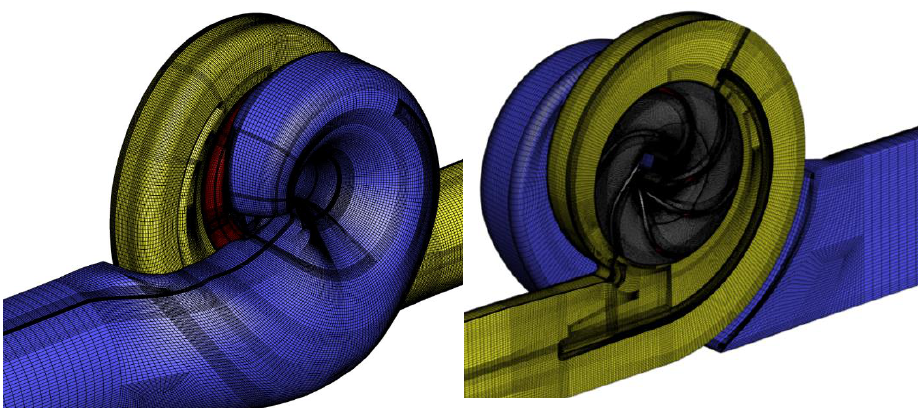
Figure 9. Multi-block structured hexagonal mesh of double-volute double-suction pump.